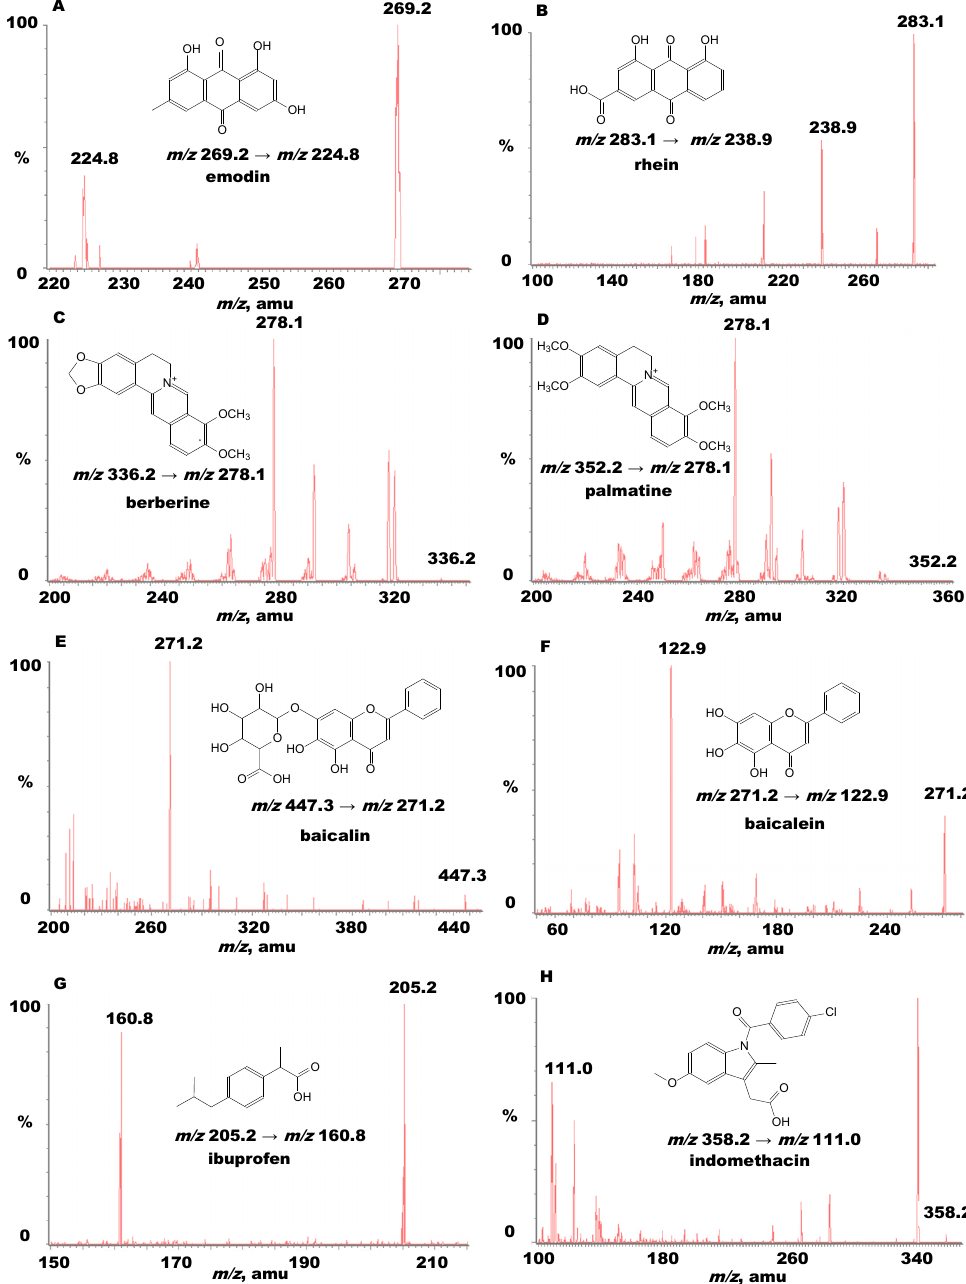
Figure 1. Chemical structures of ( A ) emodin; ( B ) rhein; ( C ) berberine; ( D ) palmatine; ( E ) baicalin; ( F ) baicalein; ( G ) ibuprofen; and ( H ) indomethacin (molecular weight 270, 284, 336, 352, 446, 270, 206, and 357, respectively). Mass spectra of the analytes and their product ions in UPLC-MS/MS with electrospray negative or positive ion mode. The mass transitions of emodin, rhein, berberine, palmatine, baicalin, baicalein, ibuprofen, and indomethacin were m/z 269.2 → 224.8, 283.1 → 238.9, 336.2 → 278.1, 352.2 → 278.1, 447.3 → 271.2, 271.2 → 122.9, 205.2 → 160.8, 358.2 → 111.0,